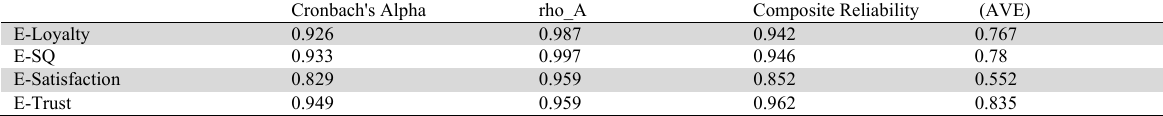
Cronbach's Alpha, Composite Reliability, and Average Variance Extracted (AVE)